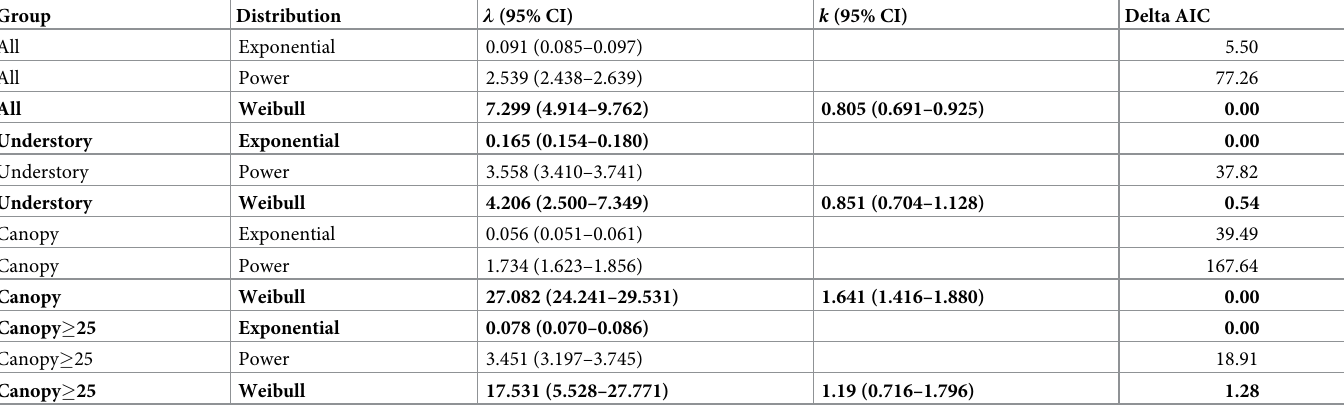
Table 2. Parameter values and delta AIC values for maximum likelihood fits of exponential, power and Weibull probability density functions to size distributions for all trees, understory trees, canopy trees, and canopy trees � 25 cm